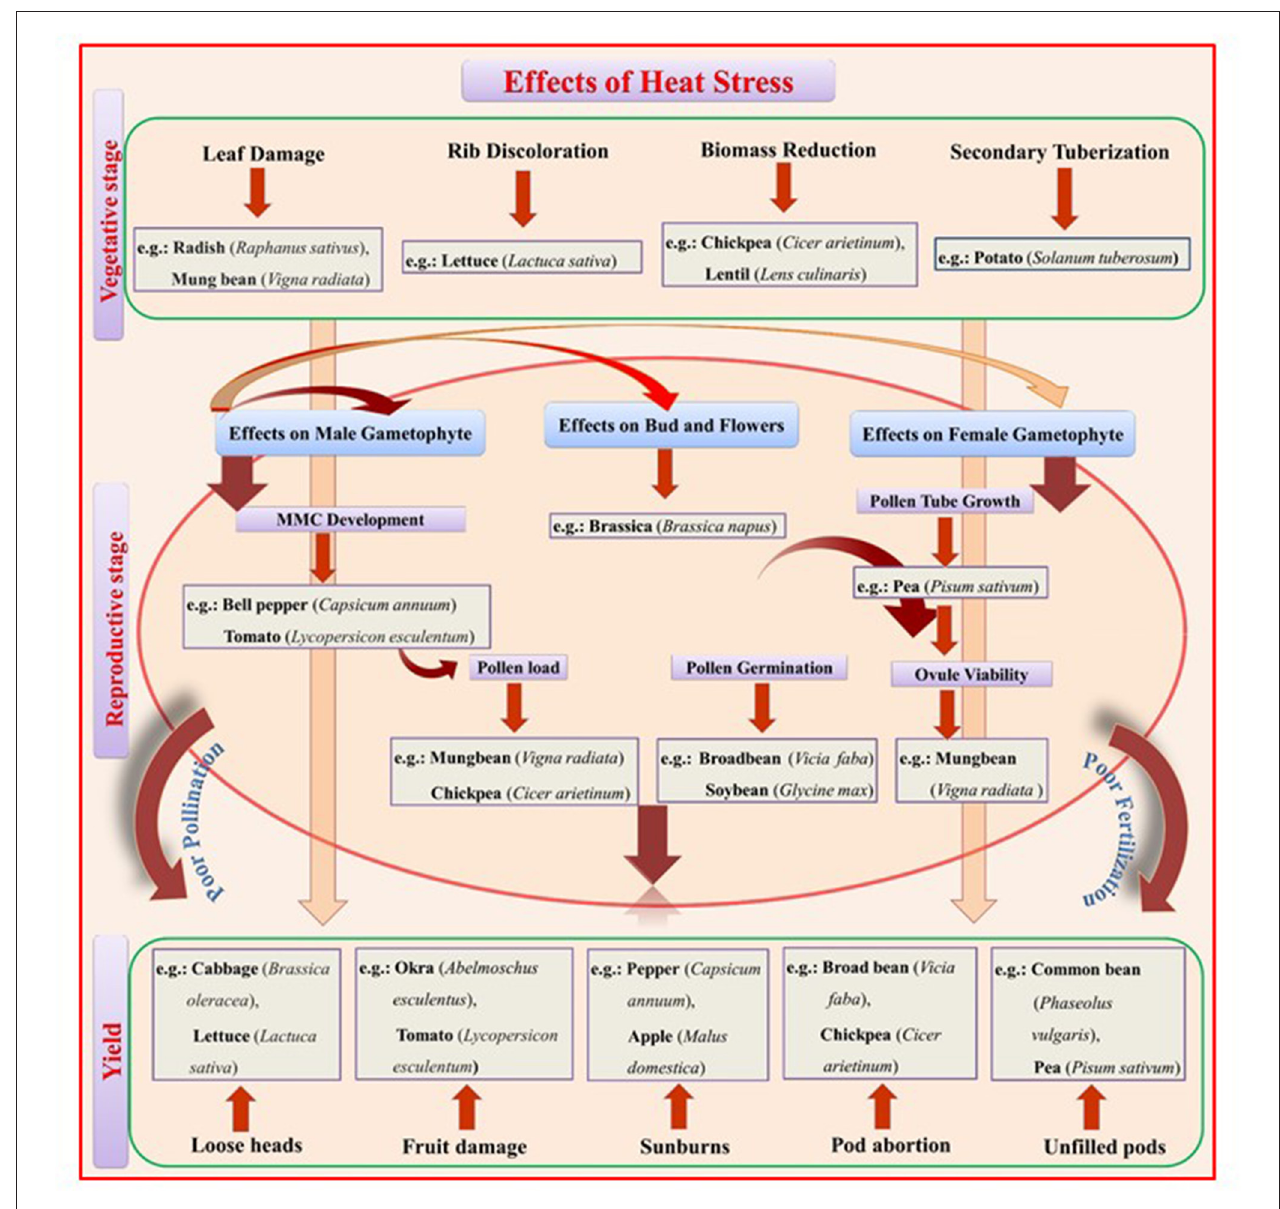
FIGURE 1 | A schematic representation of the effects of heat stress (HS) on vegetative and reproductive growth stages that reduce yield. Heat stress at the vegetative stage promotes leaf damage, rib discoloration in leafy vegetables, biomass reduction in food legumes, and secondary tuberization in potato. Heat stress at the reproductive stage negatively affects the overall route from Microspore Mother Cell (MMC) development to fruit setting/seed filling through pollination and fertilization. The male gametophyte is more prone to heat stress, leading to poor pollen germination, pollen load, and pollen tube growth inside the style and inability to fertilize the ovule at the required